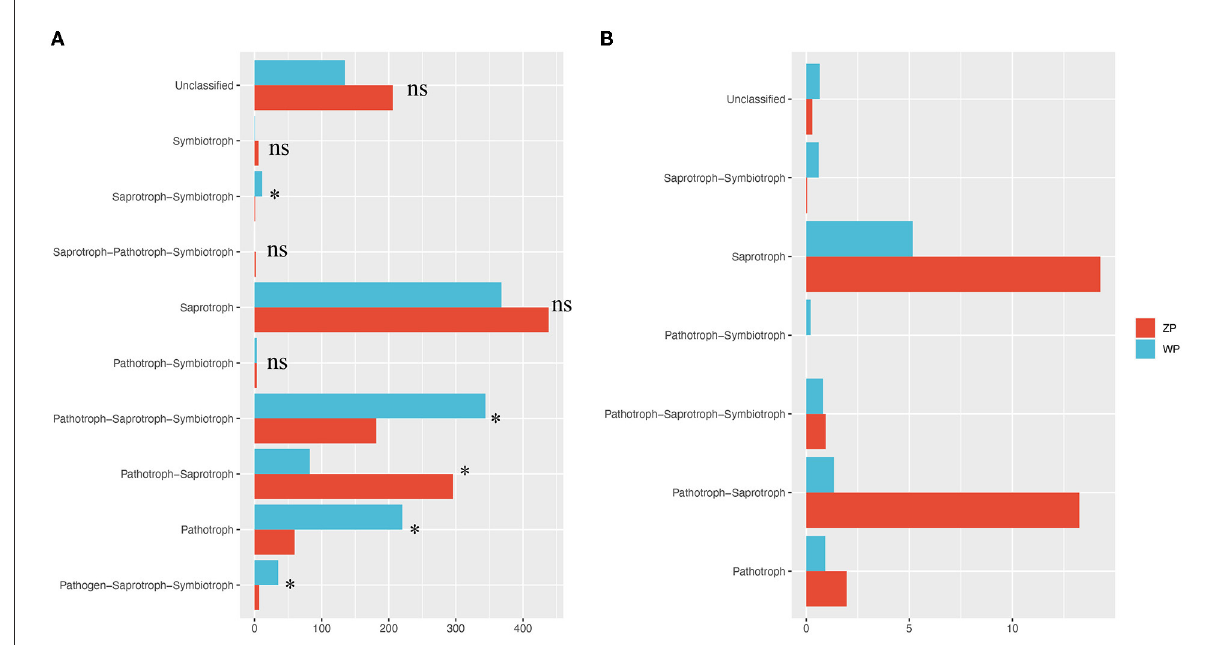
FIGURE9 Functional community composition. (A) The functional composition of all compartments, (B) The functional composition of core community. * P -value < 0.05.